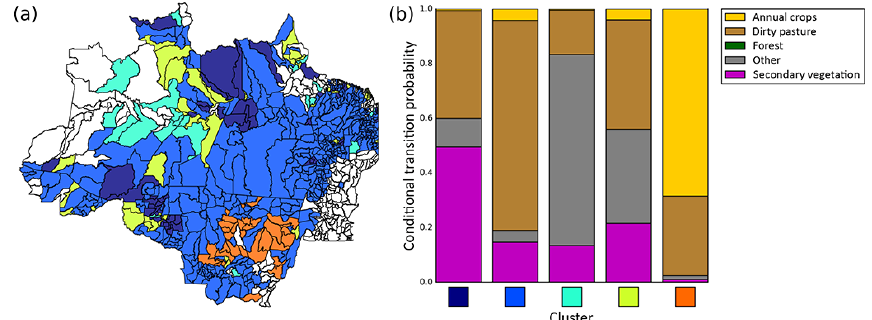
Figure 8. (a) Hierarchical clustering with conditionally normalized transition probabilities from clean pasture to other land-cover classes between 2010 and 2012, as in Fig. 7c. (b) Cluster centroids showing the conditional transition probabilities of the average over the respective cluster indicated by cluster